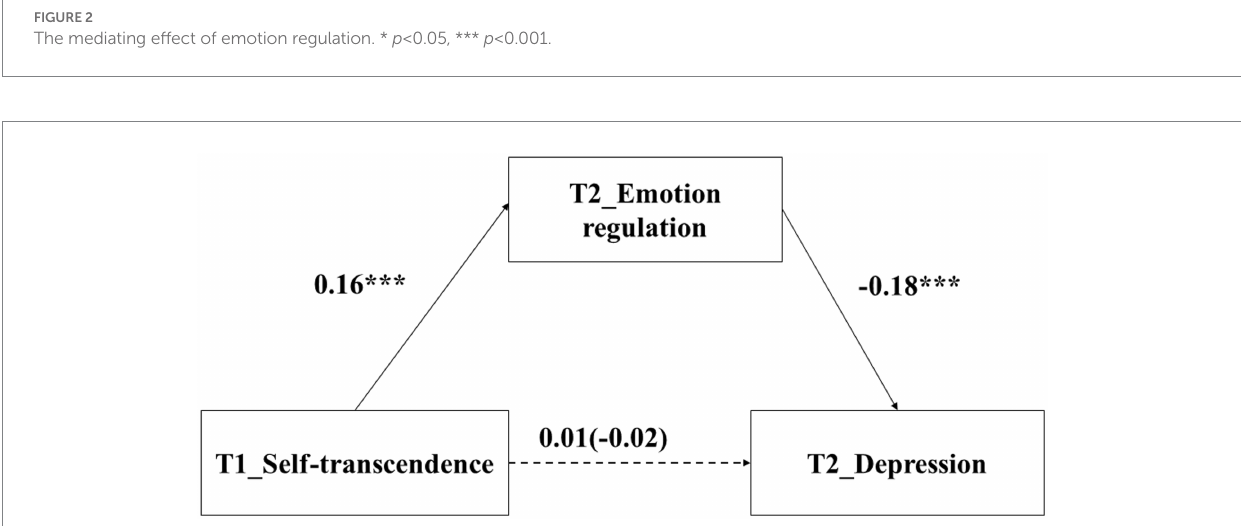
FIGURE 3 The mediating effect of emotion regulation. *** p <